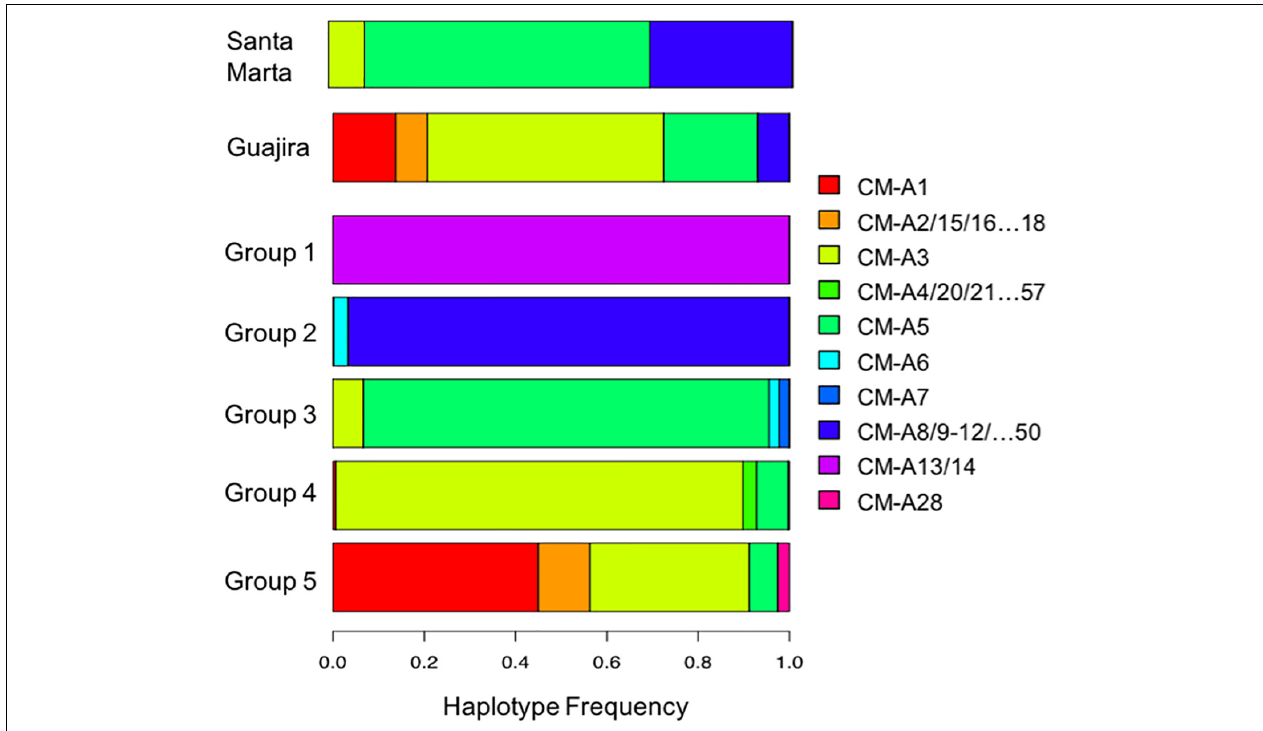
FIGURE 2 | Mitochondrial Control Region haplotypes frequency of Chelonia mydas (NRs) groups and two foraging grounds (FGs) in northeastern Colombia according to SAMOVA. Horizontal axis shows the color of each C. mydas (CM) haplotype. Haplotypes with very low frequencies but of the same lineage were compiled within the same color